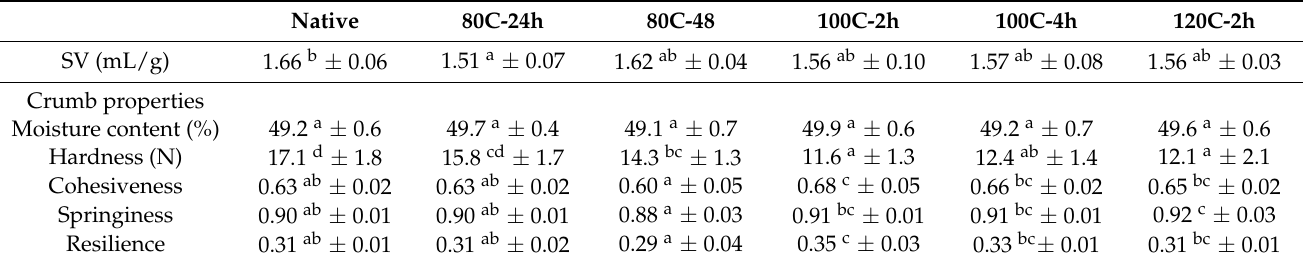
Table 3. Bread properties as affected by native and dry-heated CPF. For the dry-heated CPF samples, the temperature (C) and time (h) treatment conditions are indicated by the